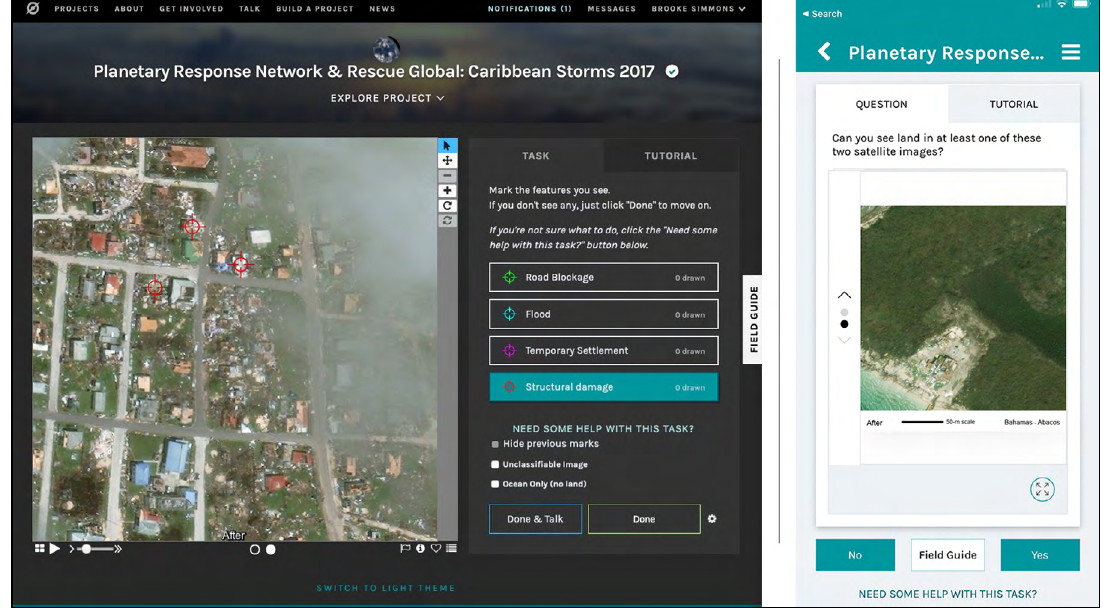
Figure 1 Example web ( left ) and mobile ( right ) interface for Zooniverse Planetary Response Network projects. Left: Image shown: Barbuda, September 2017. Right: Image shown: Bahamas, September 2019. Satellite imagery credit: Maxar Technologies’ Open Data